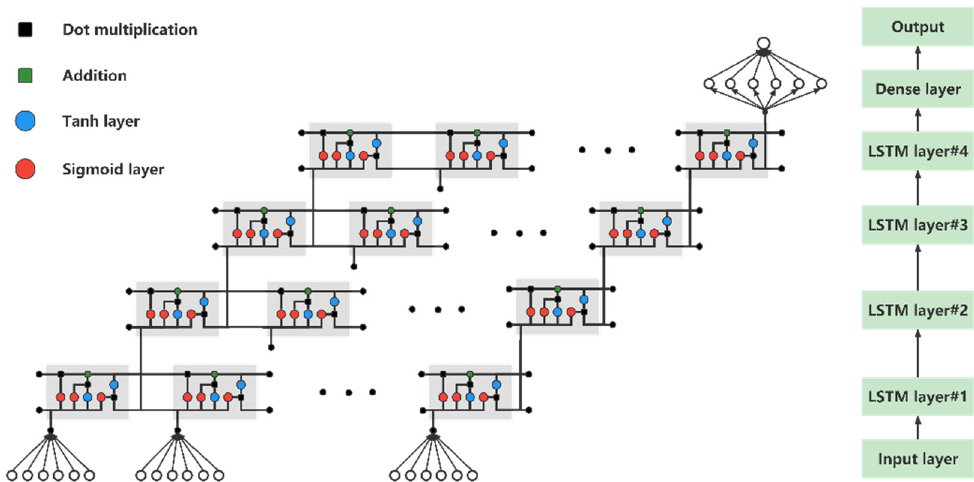
Figure 5. Schematic diagram of BI-LSTM in this work .